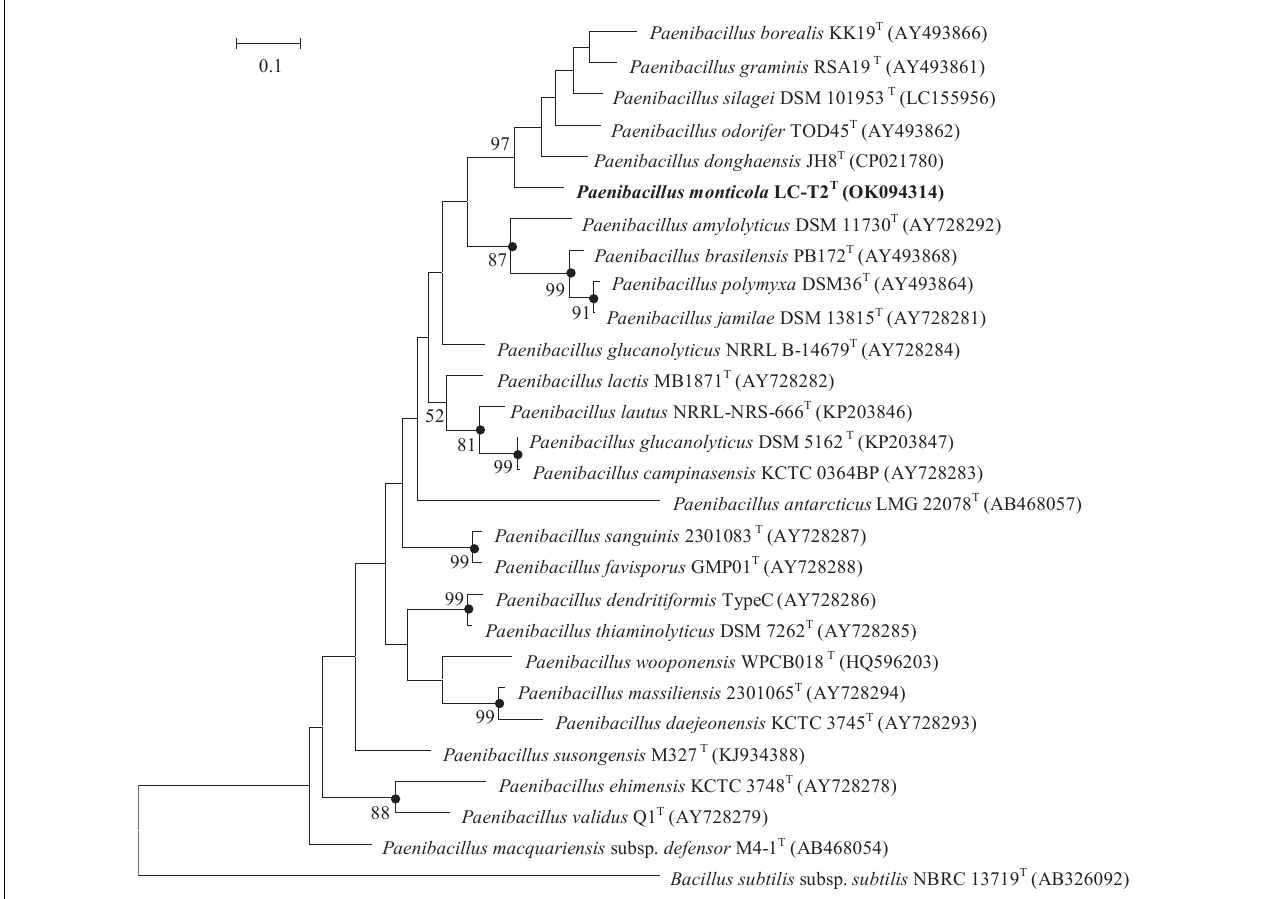
FIGURE 1 | Maximum Likelihood phylogenetic trees based on partial rpoB gene sequences showing the relationships between strain LC-T2 T and closely related species. Bacillus subtilis subsp. subtilis NBRC 13719 T was used as the outgroups. Numbers at branching points are bootstrap values > 50%. Bar, 0.1 substitutions per nucleotide position. Filled circles indicate that the corresponding nodes were also formed in neighbor-joining and maximum-parsimony trees. rpoB gene sequences of Paenibacillus donghaensis JH8 T was obtained from the genome sequence of strain P. donghaensis JH8 T .